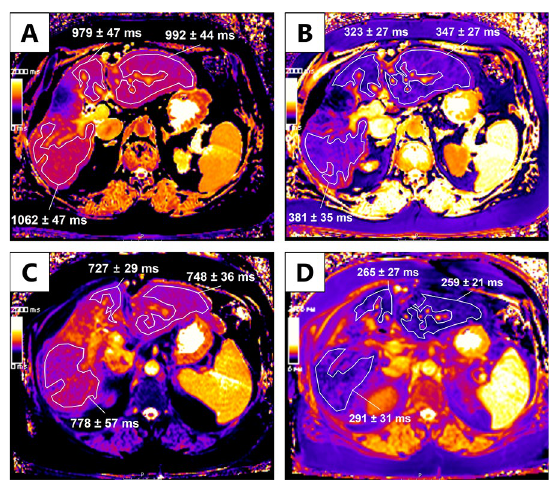
Figure 7. Correlation of the T1 reduction rates in a patient with exams at 1.5 T and 3 T. This figure shows images from a 54-year-old male patient with alcoholic liver cirrhosis Child A, who underwent both examination at 3 T ( A , B ) and 1.5 T ( C , D ) 160 days apart. The color bar on the left side of each figure serves as a legend for the color representation of the T1 relaxation time. Each bar ranges from 0 ms (dark) to 2000 ms (bright). In ( A ) and ( C ), measurements in the T1 map before the application of Gd-EOB-DTPA are shown. In ( B ) and ( D ), measurements in the T1 map 20 min after the application of Gd-EOB-DTPA are shown. At 3 T, we calculated a